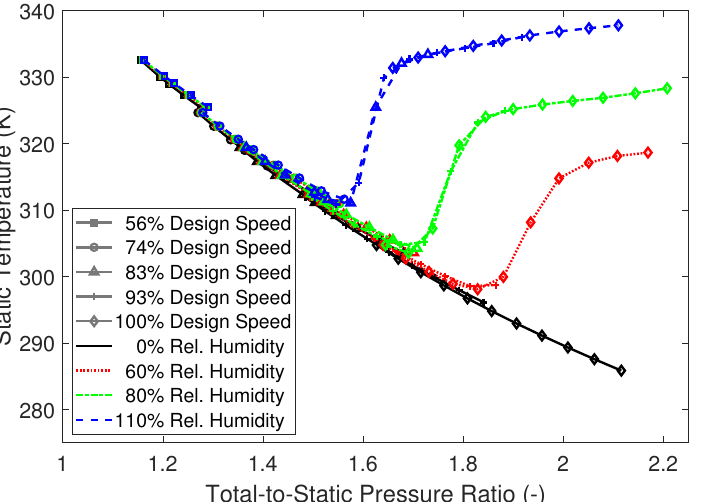
Figure 7. Static temperature of the turbine outlet for five turbine rotor speeds in dependence of the total-to-static pressure ratio. Adapted from [10]. Copyright 2021